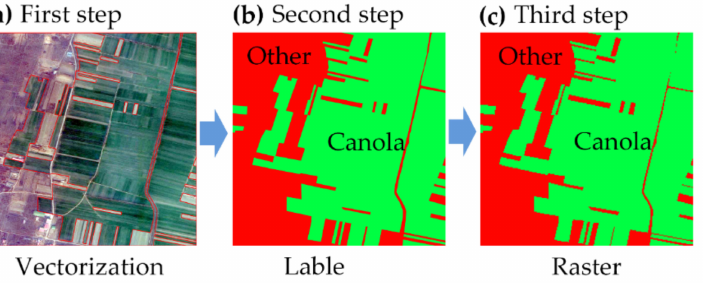
Figure 4. The validation quadrats data production process. ( a ) The Google imagery base map with a spatial resolution of 0.1 m × 0.1 m, and the red lines are the vectorized boundaries of different objects. ( b ) The green vector data are canola fields, and the red areas represent other objects. ( c ) The raster data derived from the second